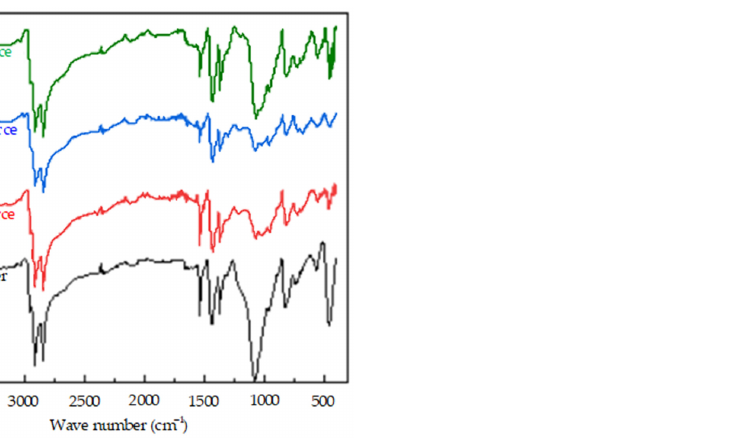
Figure 9. The infrared spectrum of the crumb rubber powder prepared by the mechanochemical activation treatment method using different adjuvants.